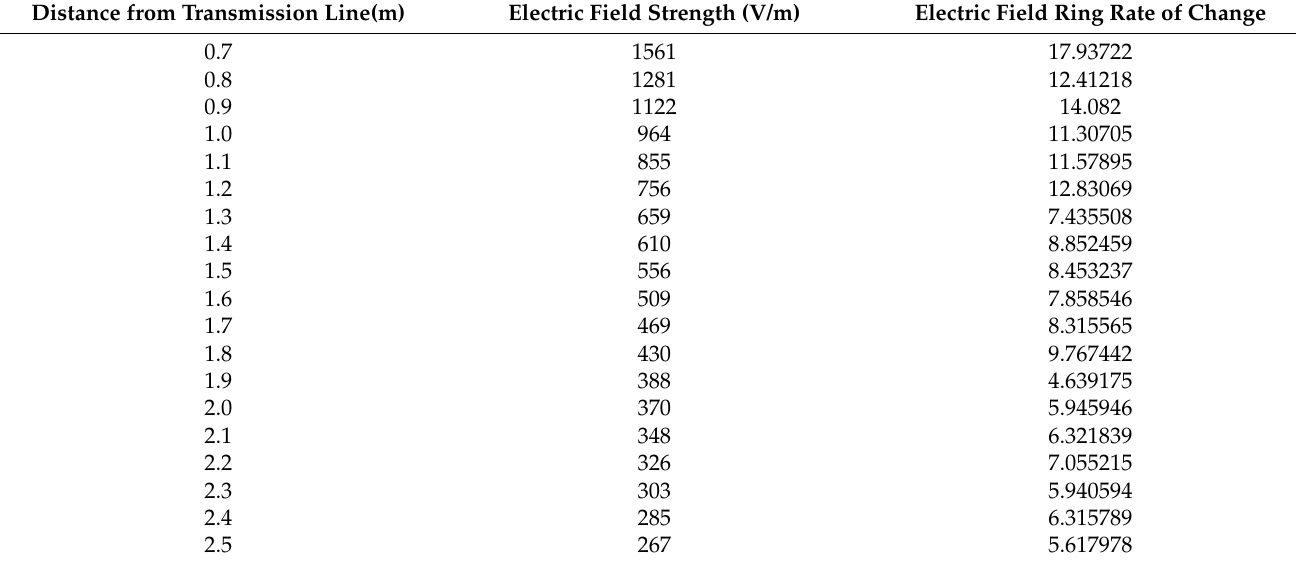
Table 5. Safety distance under different arrangement modes of 110 kV.